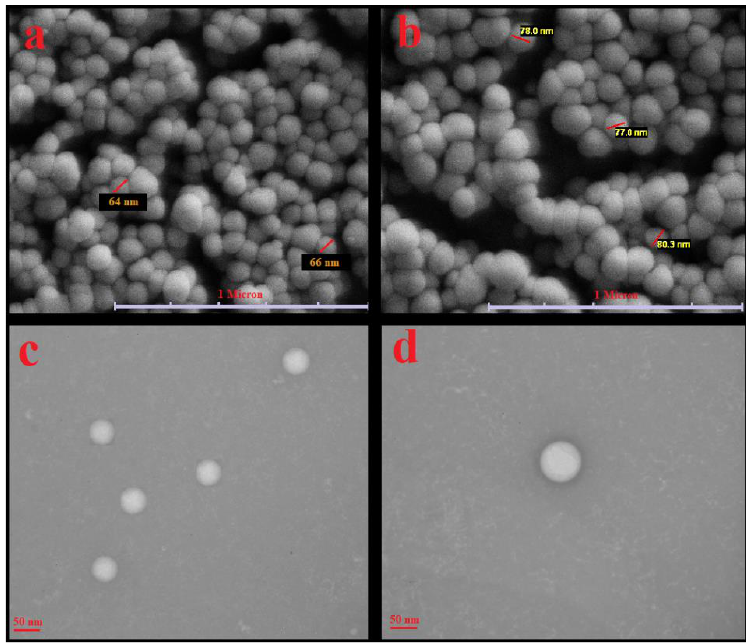
Figure 2. ( a , b ) SEM and ( c , d ) TEM images of primary liposomes stabilized with γ -oryzanol ( a , c ) and corresponding γ -oryzanol-chitosomes ( b , d ). corresponding γ -oryzanol-chitosomes ( b , d